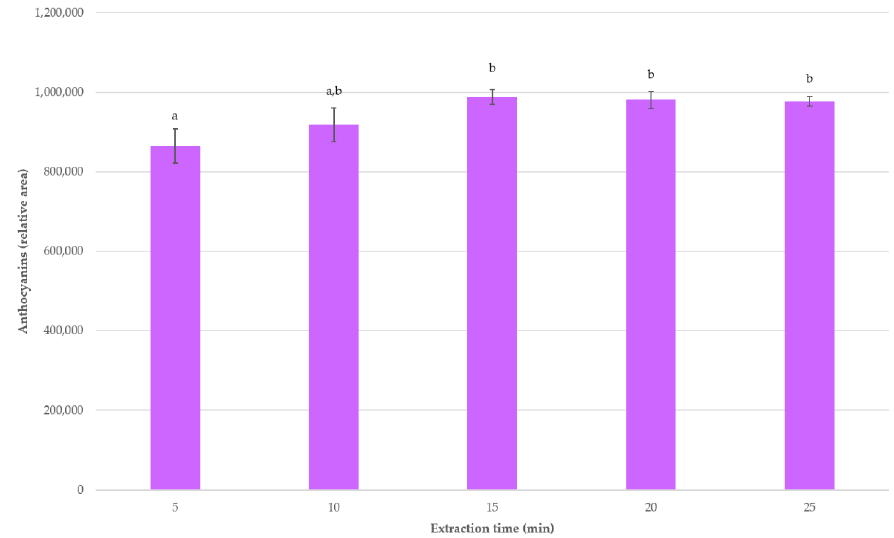
Figure 5. Average anthocyanins recoveries ( n = 3) at different extraction times under the established UAE optimum conditions. A different letter over a bar indicates a significant difference ( p -value < 0.05).